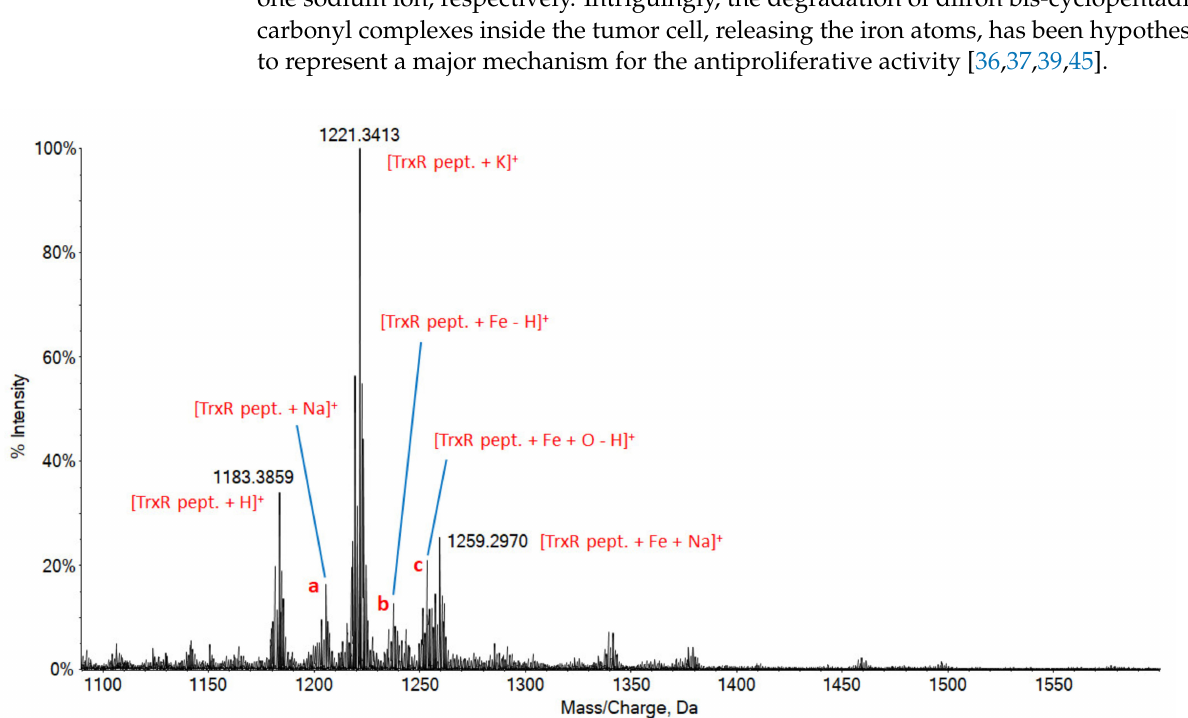
Figure 4. High-resolution ESI mass spectrum of 1e incubated for 24h at 37 ◦ C with 10 − 5 M TrxR-pept solution in water; 1:1 peptide to complex ratio. 0.1% v / v of formic acid was added just before infusion. Unlabeled peaks: a , m / z 1205.3771; b , m / z 1237.3218; c , m / z